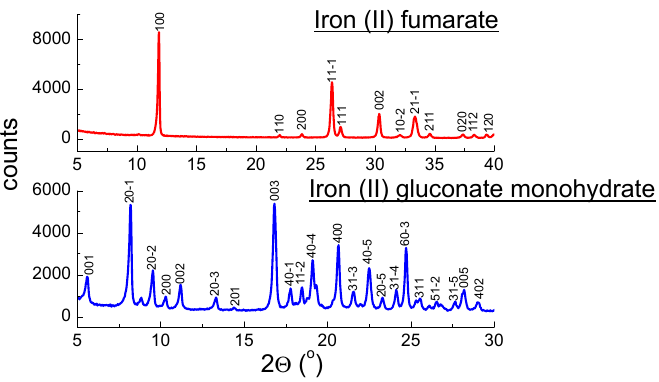
Figure 1. Diffraction patterns of iron (II) gluconate monohydrate and iron (II) fumarate. Analysis of a diffraction pattern and obtained crystal data of pure iron (II) fumarate perfectly aligned with the PDF card 00-0062-1294 [30]. Similarly, crystal data and diffrac- tion pattern of pure iron (II) gluconate are in good agreement with the data presented in [33]. The X-ray analysis was done for iron (II) gluconate monohydrate and iron (II) glu- conate dihydrate. The diffraction pattern for both compounds is very similar. The XRPD method does not distinguish both forms of iron (II) gluconate. The other iron com- pounds included in the studied dietary supplements: iron (III) citrate and iron (III) py- rophosphate are amorphous substances. Structural parameters cannot be determined for these compounds. Although the diffraction pattern of iron (II) bisglycinate indicates amorphous properties, the diffractogram of the pure iron (II) bisglycinate showed a characteristic shape with two diffraction lines (Figure 2). The diffraction pattern of iron (II) bisglycinate indicated partly amorphous properties. The diffractogram of the pure iron (II) bisglycinate showed a characteristic shape with two diffraction lines (Figure 2). It allowed us to determine the values of 2 θ angles: 16.5449° and 22.6979° and to calculate the interplanar distance d hkl : 5.3536Å and 3.9143Å, respectively. Values of d hkl interplanar distances for all tested supplements were calculated based on the Bragg–Wulff equation [28].